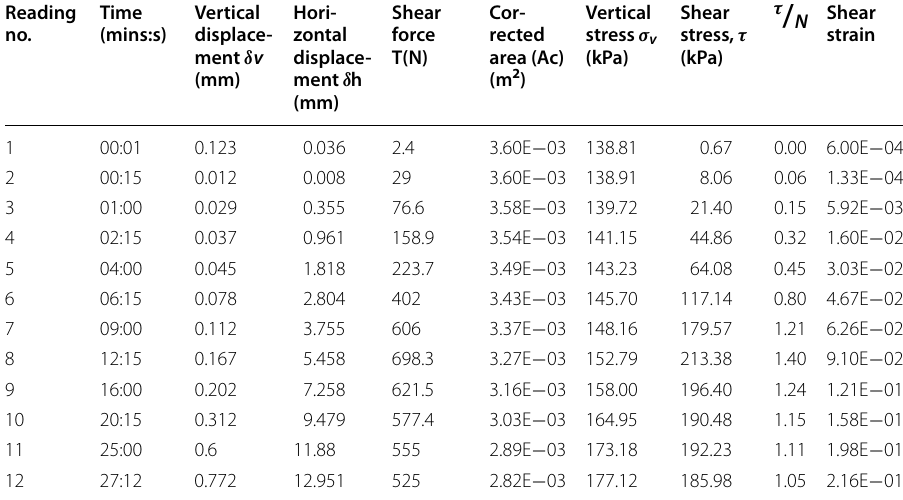
Table 3 Typical computation for test at 138 kPa normal stress for soil–concrete interface for specimen 1 in set 1 Reading